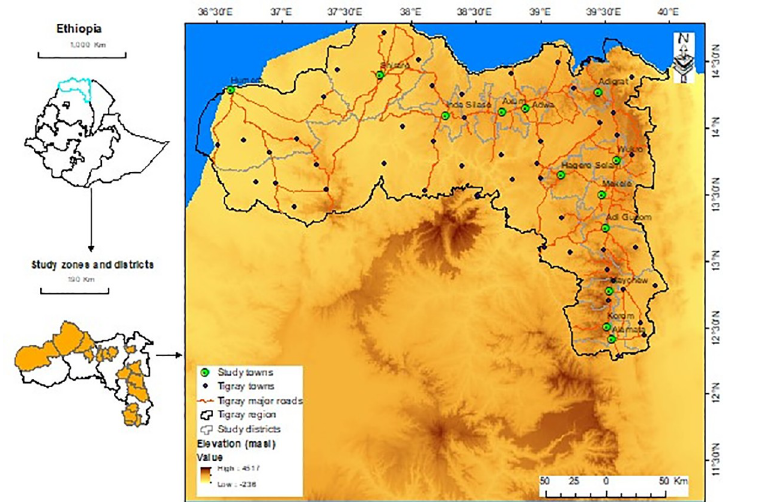
Fig 1. Map of the study zones, districts, and urban